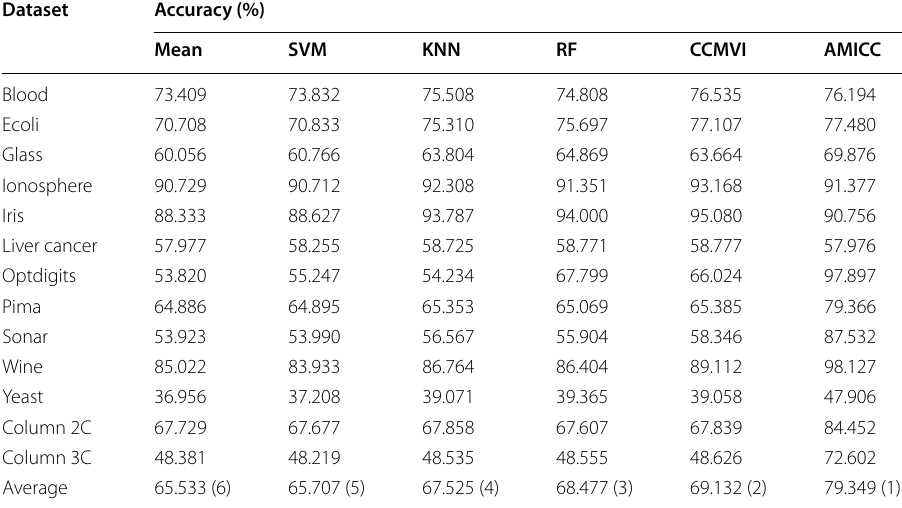
Table 7 Average classification accuracies of the MVI methods for the numerical datasets Dataset